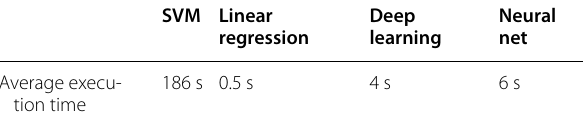
0.894) and the BIS =